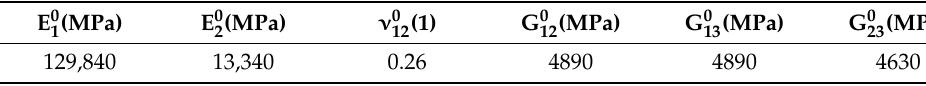
Table 1. The elastic properties of the lamina.